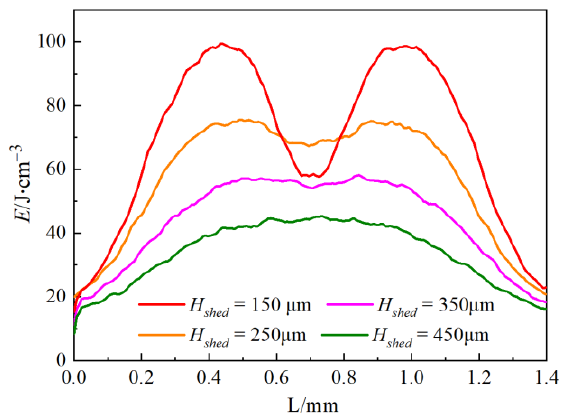
Figure 14. Effect of vessel distance to energy deposition on the axis of the deep blood vessel at D = 120 µ m and α 0 = 30 ◦ .